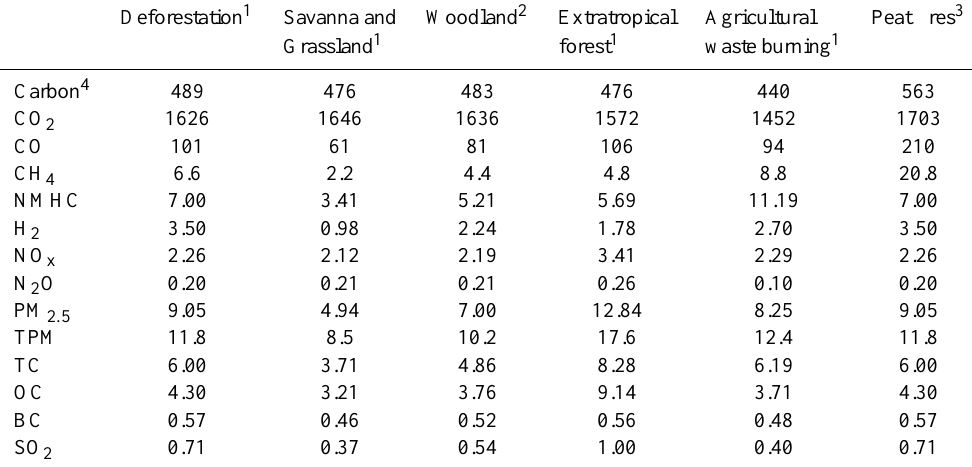
Table 5. Emission factors used for different fire types, in g specie perkg dry matter burned.